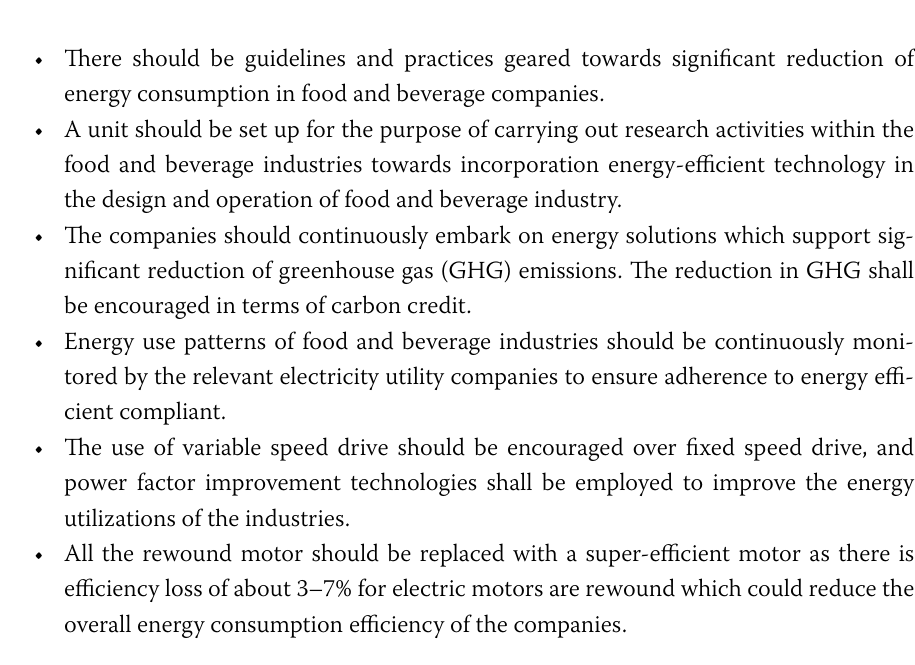
(kg/CO ) emission before and after the DSM application 2 2 Ind. A Ind. B Ind.